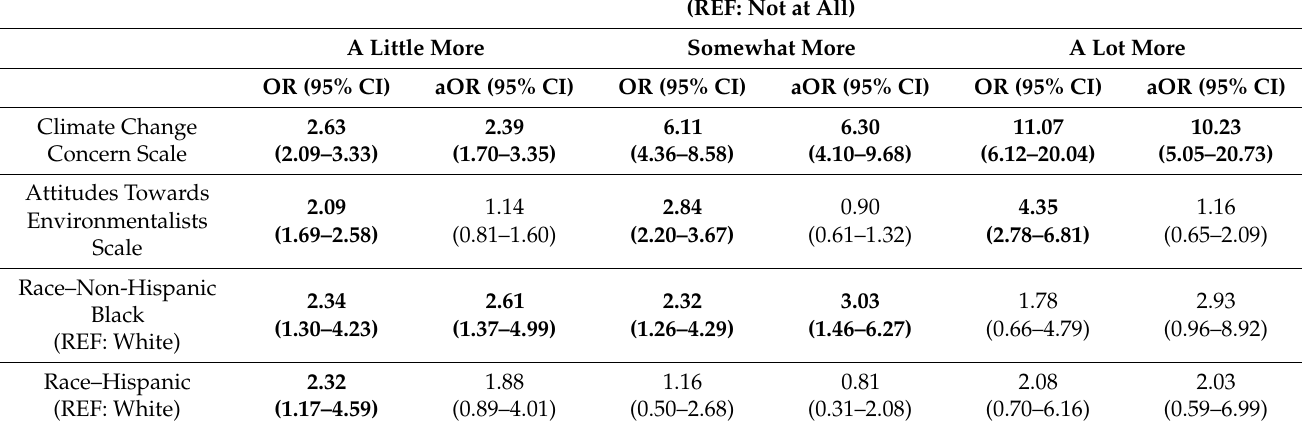
Table 5. Bivariable and multivariable model of willingness to donate or help out an organization that addresses climate change, if